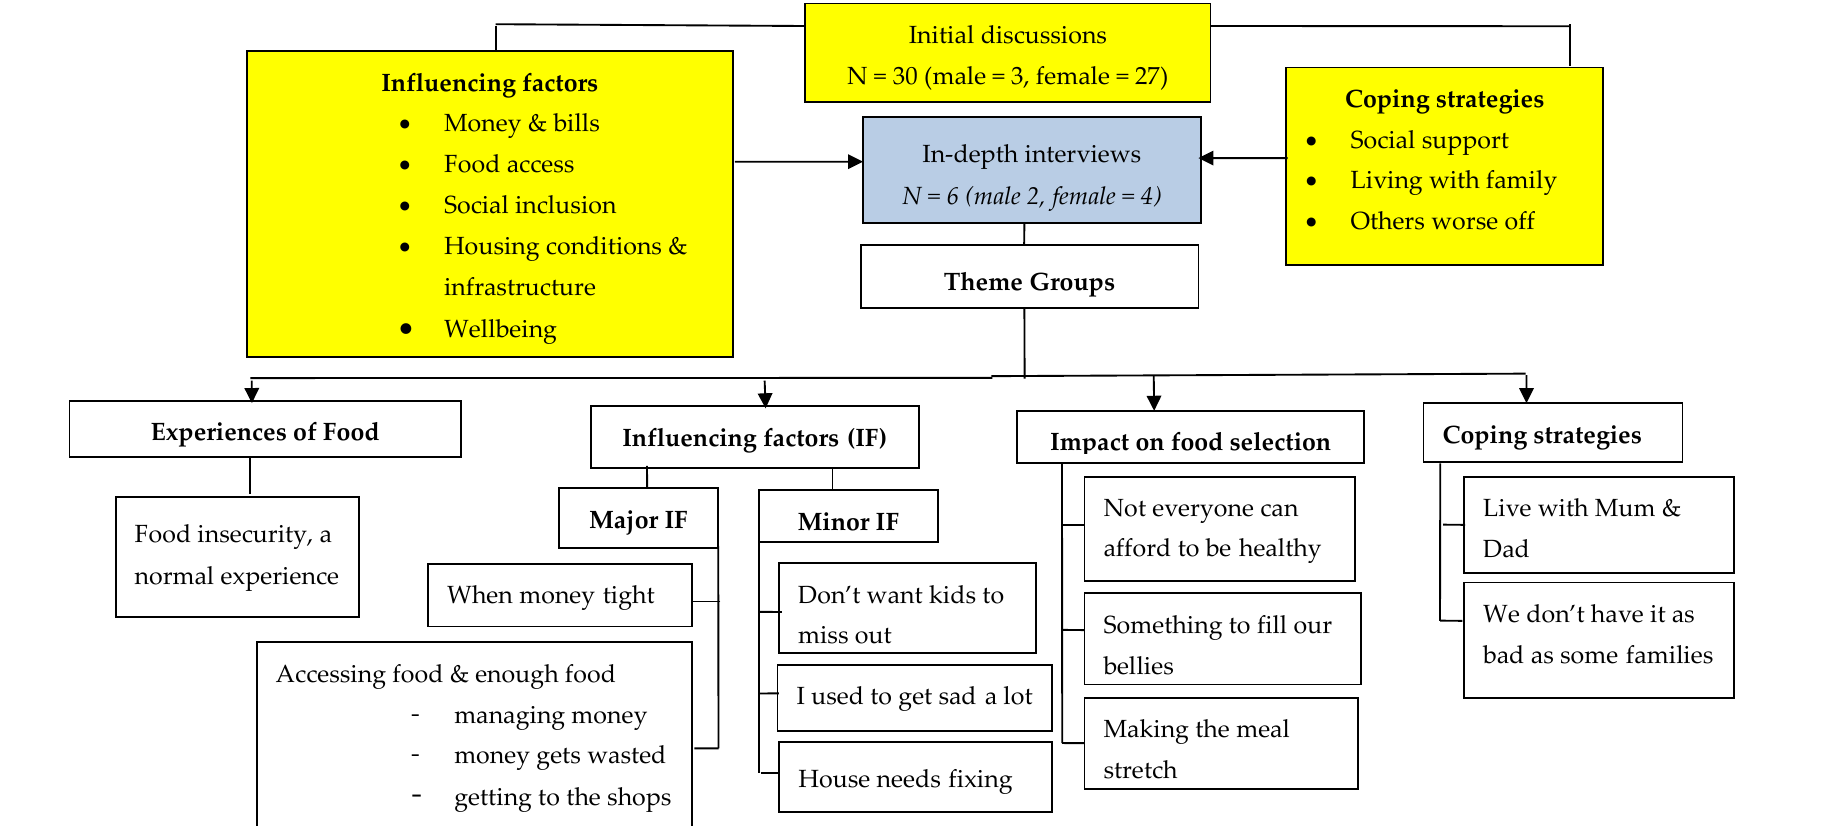
Figure 1. Overview of significant Qualitative Findings.